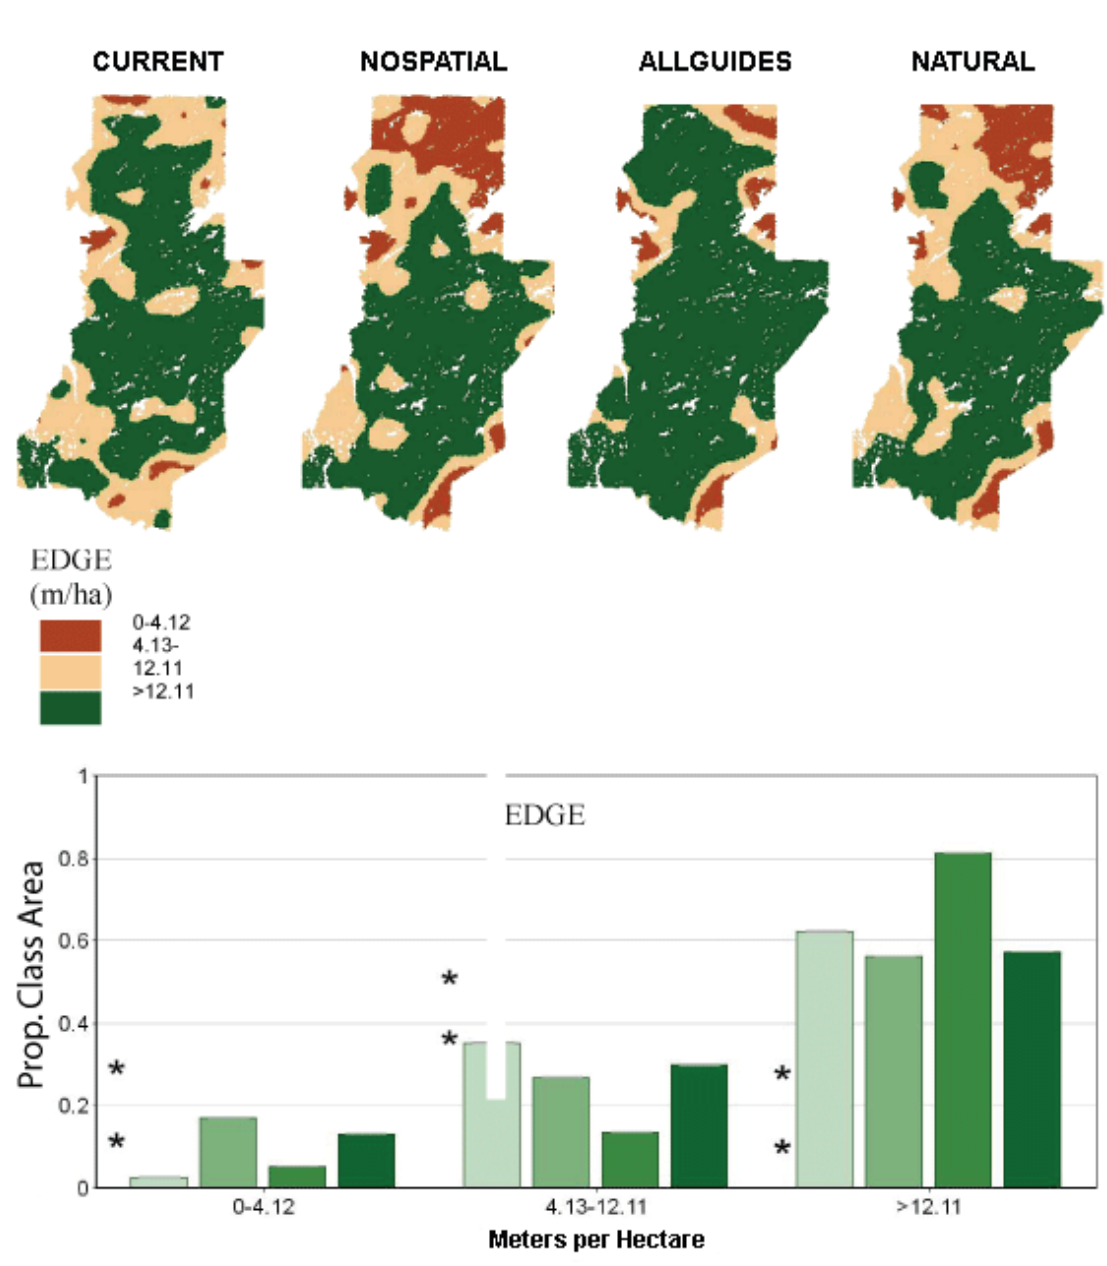
Fig. 10. Spatial pattern signatures for contrast weighted edge density (EDGE) based on Patchworks projections (year 100) of four management scenarios (see Table 2 for definitions). Histograms depict proportion of map-area for low, medium, and high EDGE for each of the four scenarios, and asterisks represent SRNV for